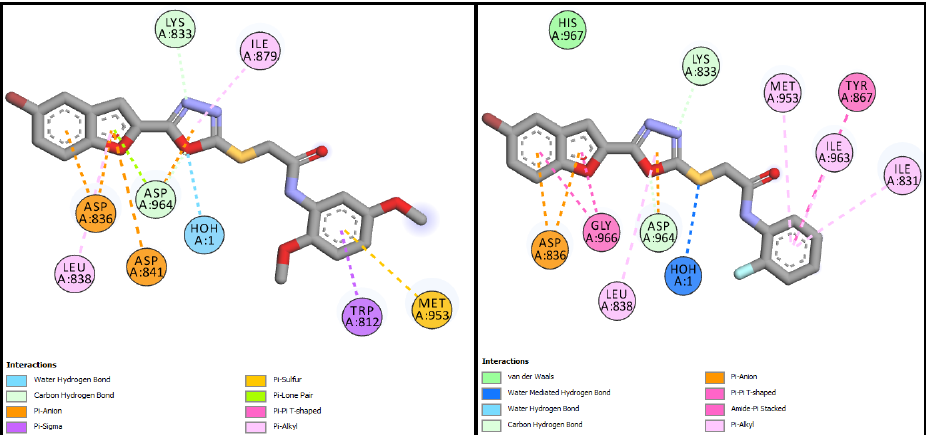
Figure 8. Two-dimensional interactive poses of BF-5 ( Left ) and BF-6 ( Right ) in the PI3K active site. Overall, three bromobenzofuran-oxadiazoles ( BF-2 , BF-5 , and BF-6 ) showed stronger binding interactions with the PI3K active site while the Idelalisib standard PI3K inhibitor was able to bind to its active site with a binding affinity of − 11.42 Kcal/mol, which suggested that these novel BF-2 , BF-5 , and BF-6 compounds could bind more strongly with the PI3K compared to the standard drugs used in our docking studies. The binding affinity energies of these three ( BF-2 , BF-5 , and BF-6 ) structural motifs arose due to the interactions of these compounds with the PI3K active pocket amino acid residues and are presented in Table 4. Table 4. Binding affinities and other docking parameters of BF-2, BF-5, and BF-6 with PI3K.